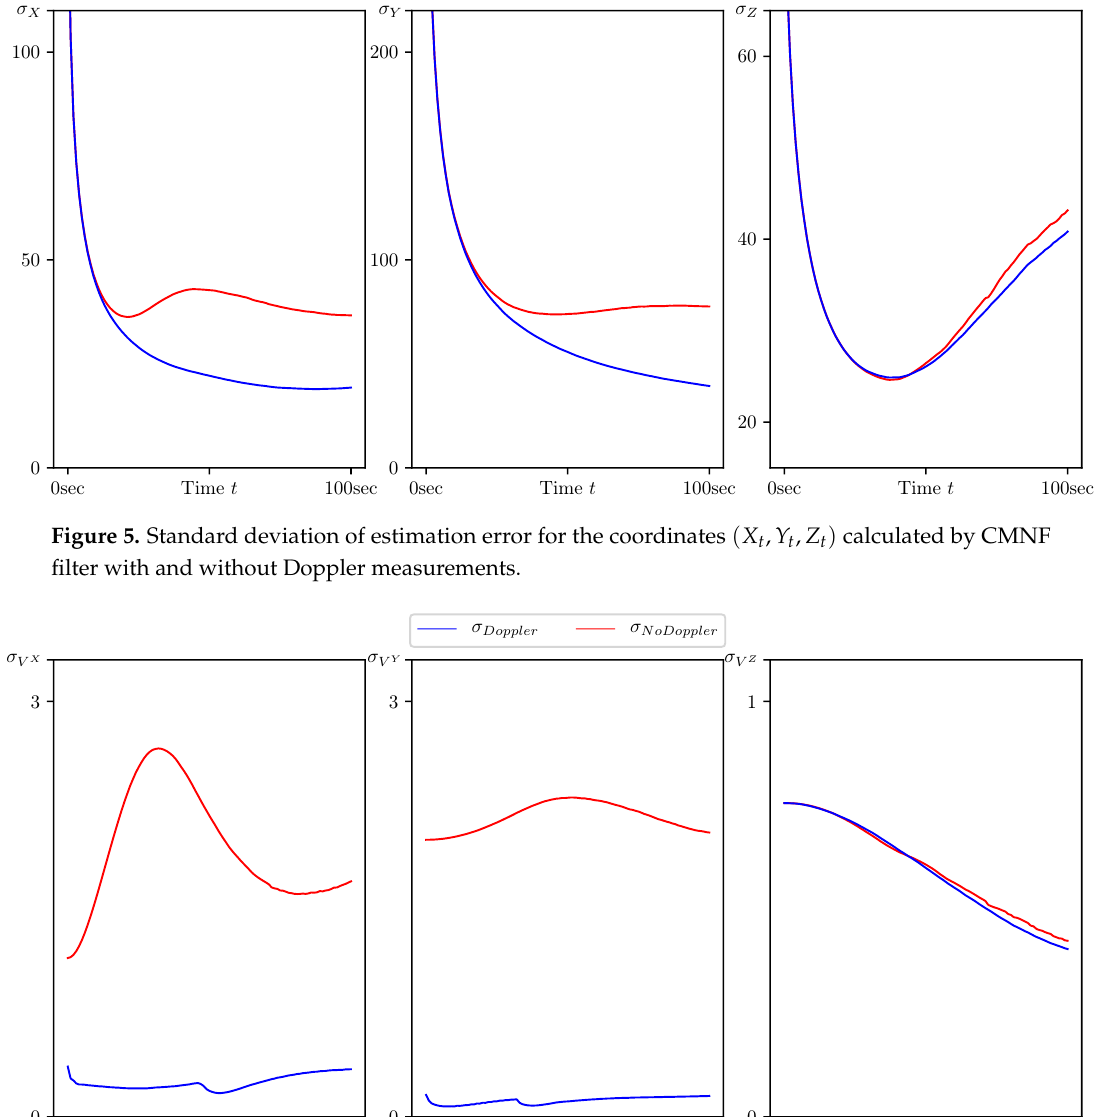
Figure 6. Standard deviation of estimation error for the target velocity components ( V X by CMNF filter with and without Doppler